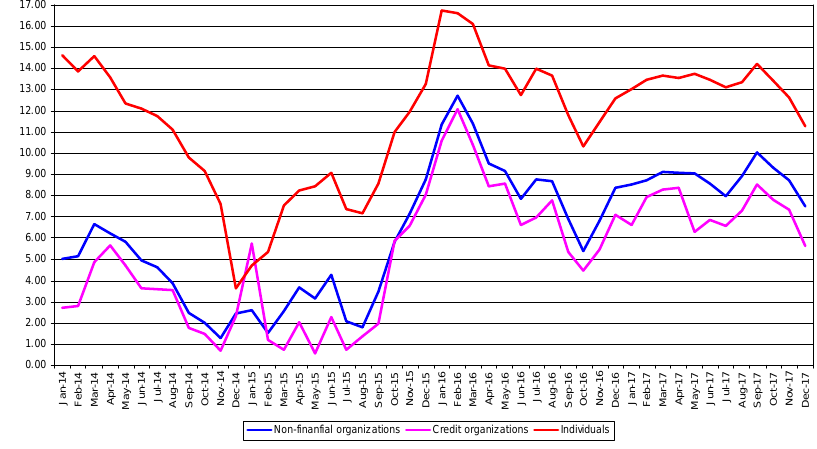
Figure 2. Dynamics of the credit market stability index for non-financial organizations, credit institutions and individuals